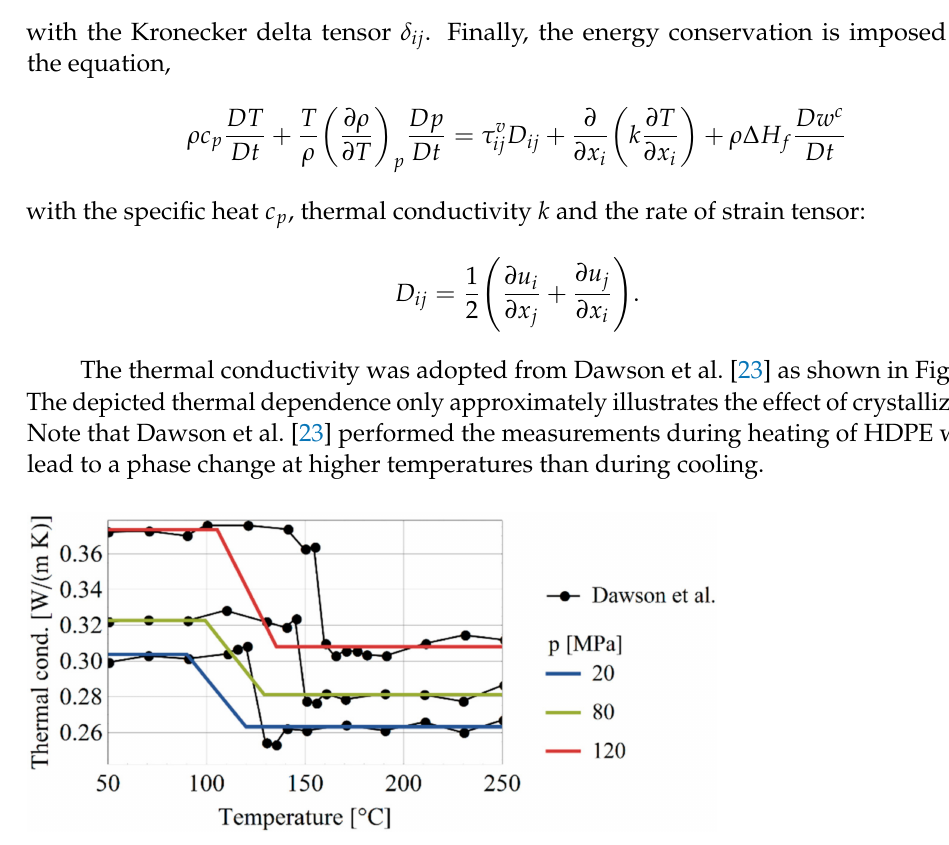
Figure 5. The thermal conductivity as measured [23] and modeled (thick horizontal